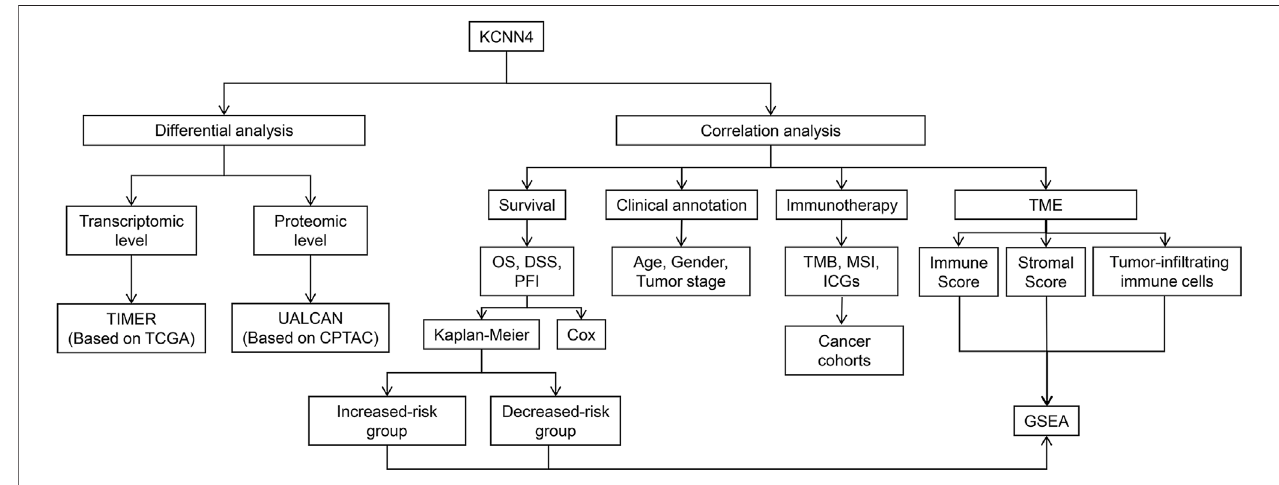
FIGURE 1 | Analytical work fl ow of